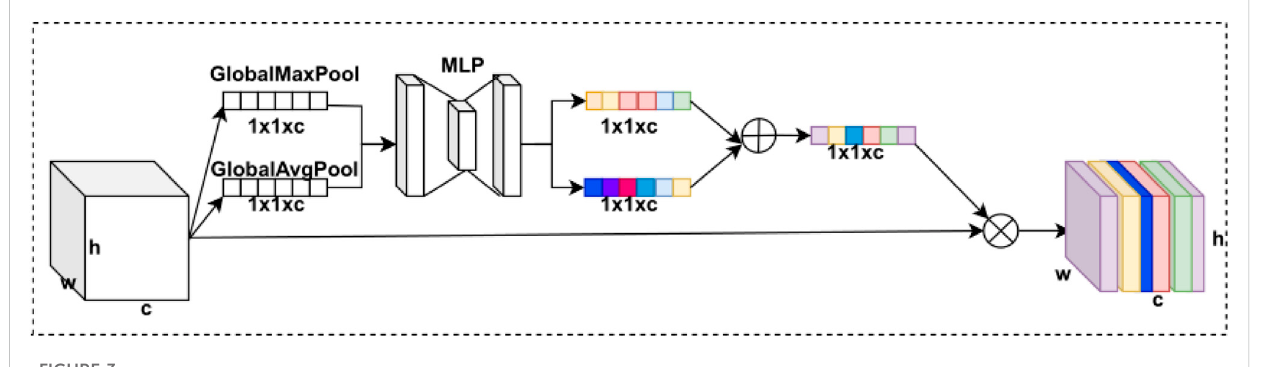
FIGURE 3 CBAM ’ s channel attention module